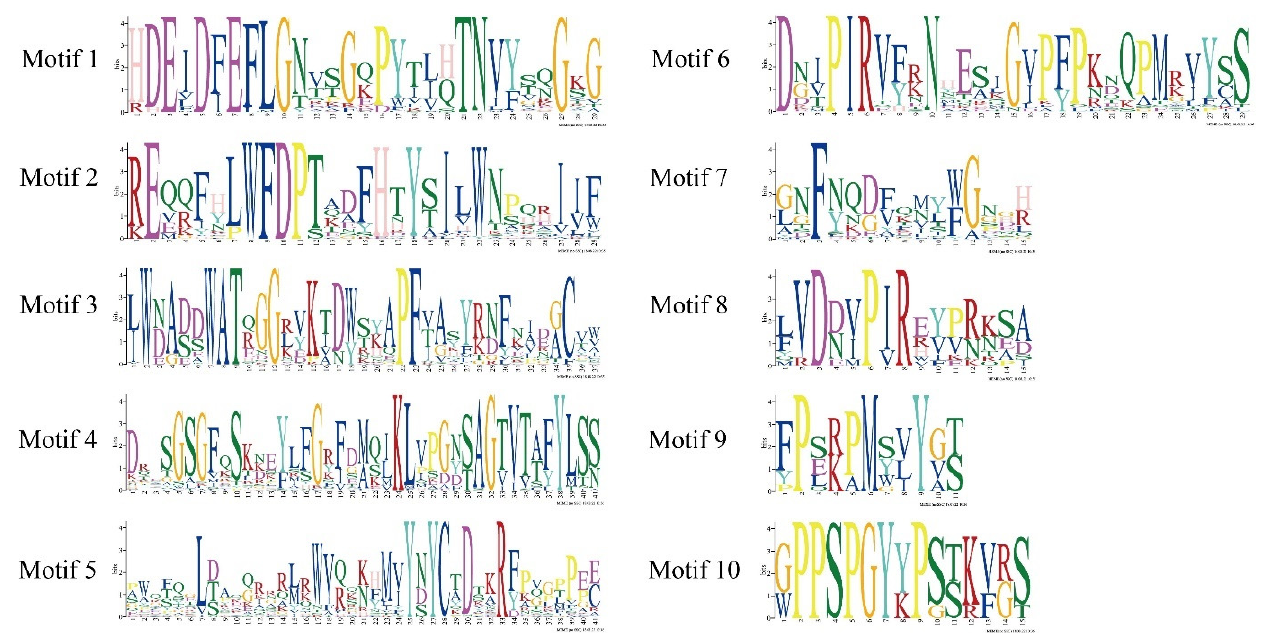
Figure 4. Schematic diagram of the core motifs of the sweet potato XTHs (Table S1); the diagram was created by MEME online program. The X-axis shows the conserved sequences of the motifs, and the conservation of residues are indicated by the height of the letters. The Y-axis represents the conservation of the amino acid.